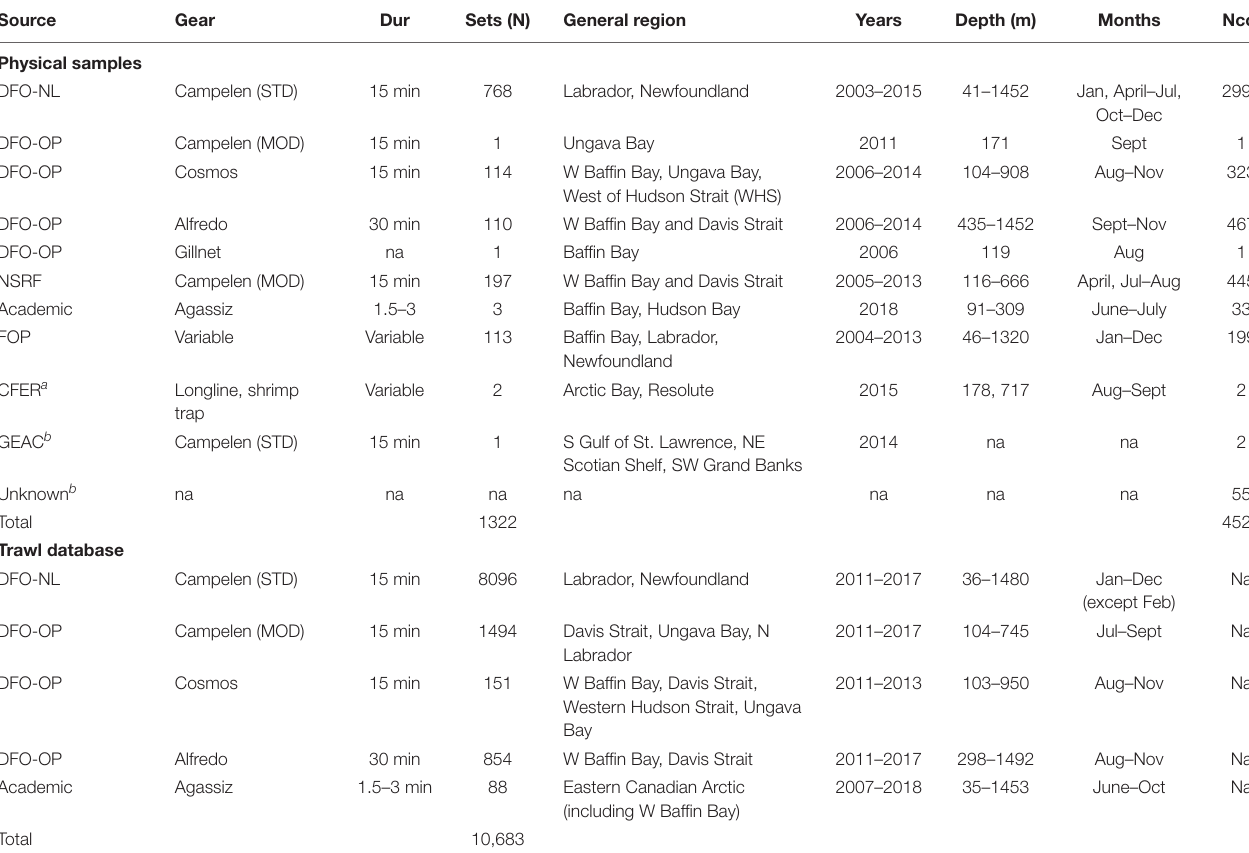
TABLE 2 | Gear (mostly trawls), mean tow duration, number of sets/stations, regions surveyed, years, months, and number of colonies per survey (Ncol) for physical samples and trawl databases. Source